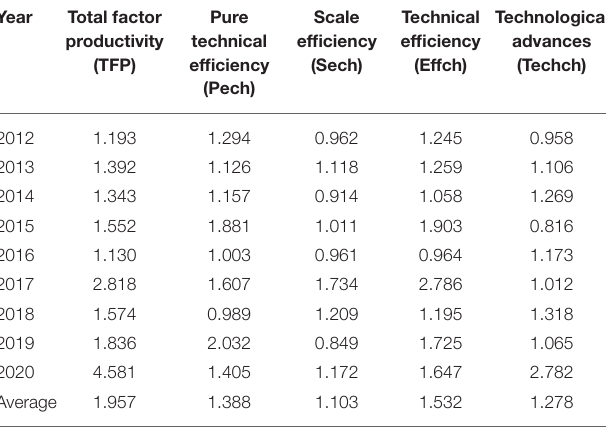
TABLE 4 | Comparison of CSR efficiency values of 17 sample enterprises in 2019 and 2020.